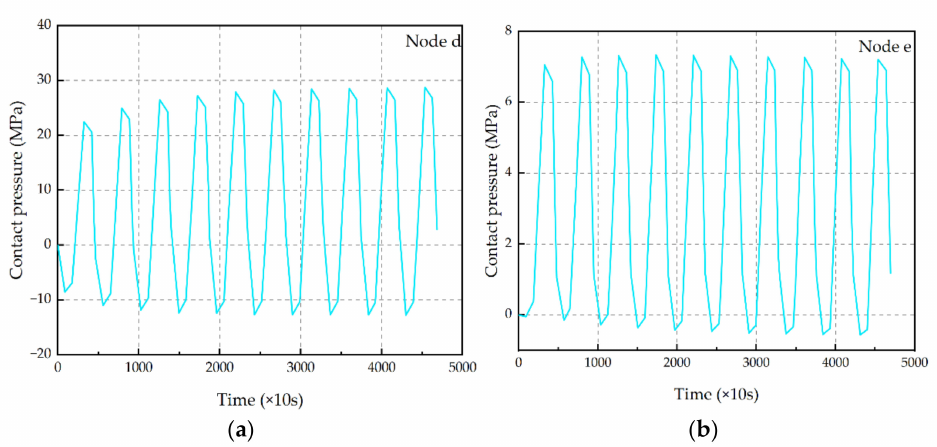
Figure 13. Contact pressure evolution in critical points. ( a ) Contact pressure evolution in critical point d; ( b ) contact pressure evolution in critical point